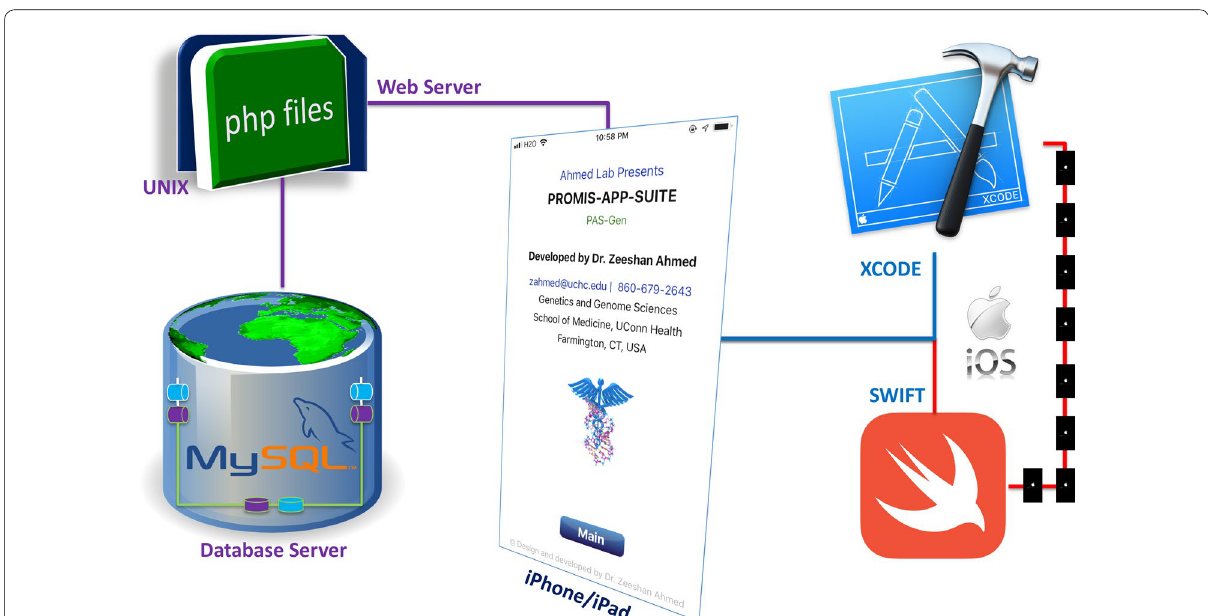
Fig. 2 PAS-Gen components design, development, and data flow. PAS-Gen is an iOS app developed with Swift programming language, XCODE integrated development environment for MacOS, MySQL database management system, PHP scripting language, and UNIX-based web and database